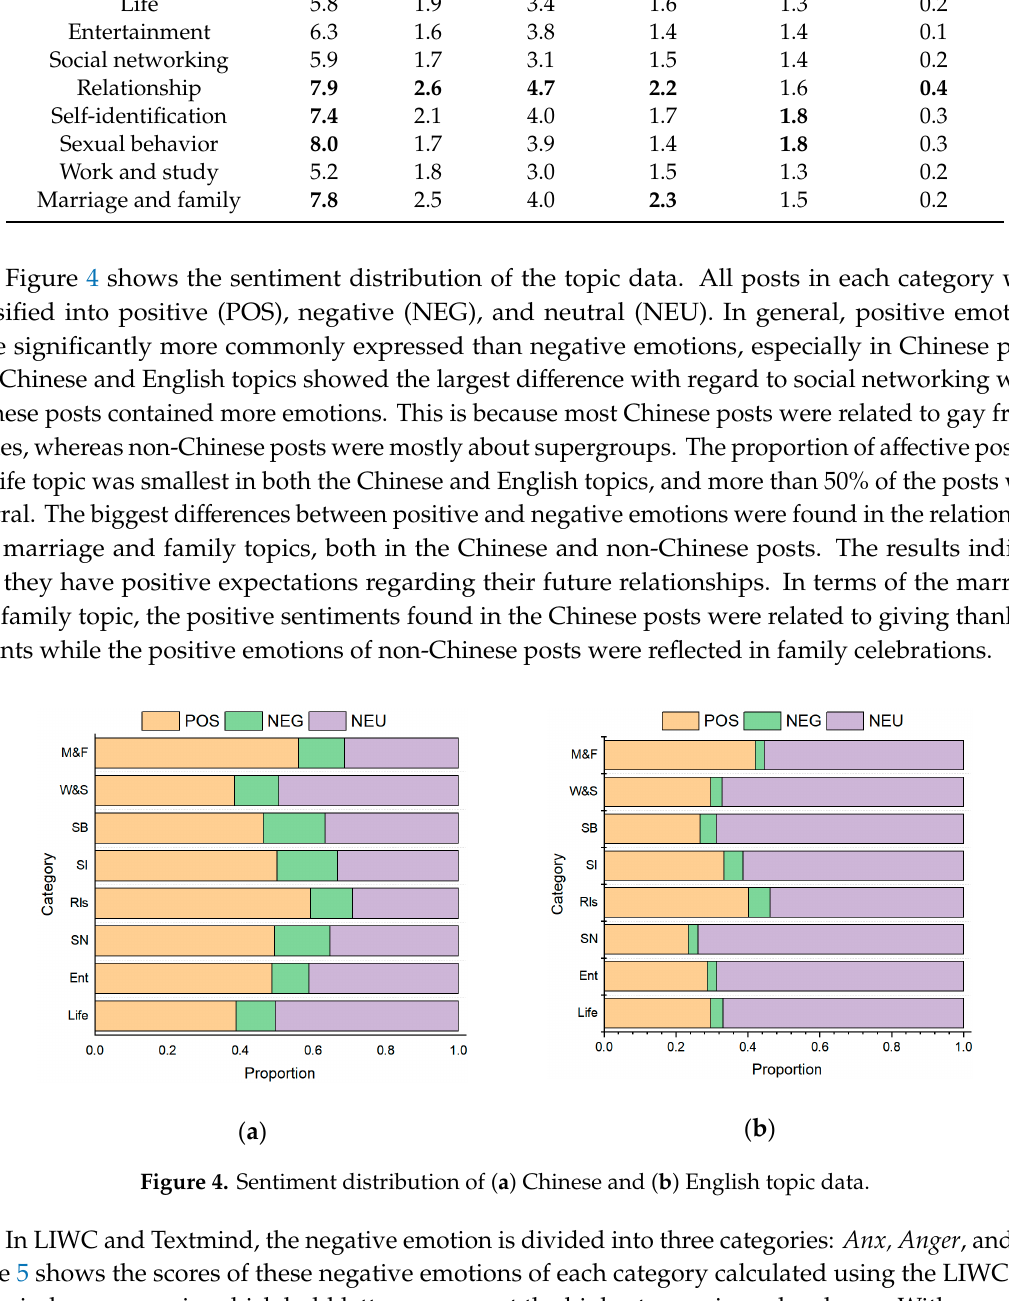
Table 5. Scores of negative emotions of each category calculated by the LIWC programs.